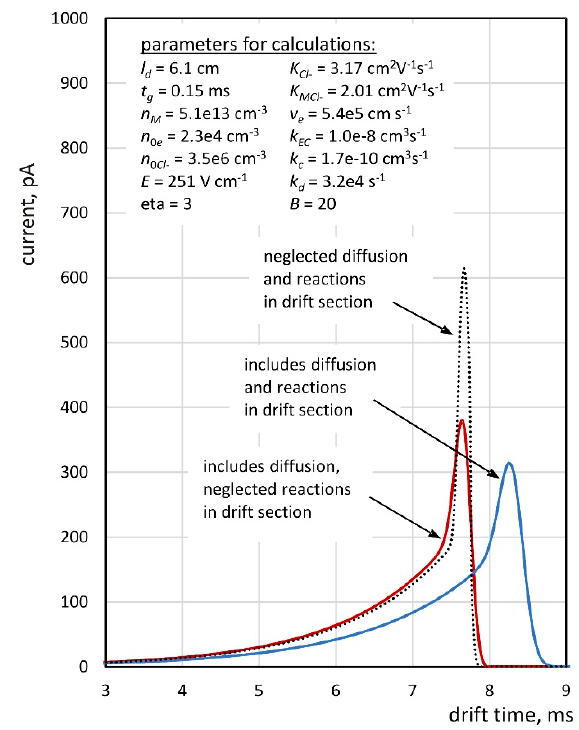
Figure 2. Time dependence of ionic current calculated without diffusion and ion–molecule reactions and taking into account these phenomena.